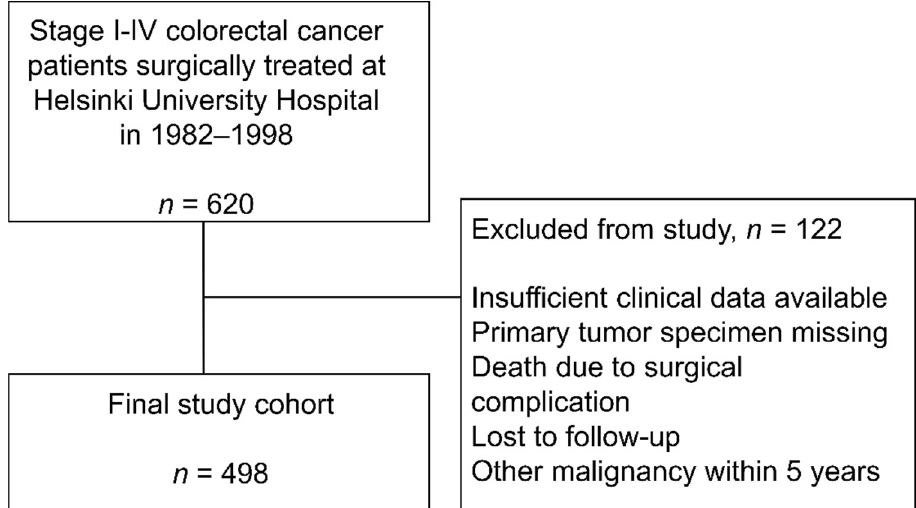
Figure 2. A flow diagram showing the inclusion and exclusion of the patients to this study. The median age of the patients was 67.4 years (22.7–90.3 years). The majority of the patients had stage II CRC. Additional patient characteristics are presented in Table 2. The median follow-up time was 4.81 years, and 46% (229/498) of the patients died during the